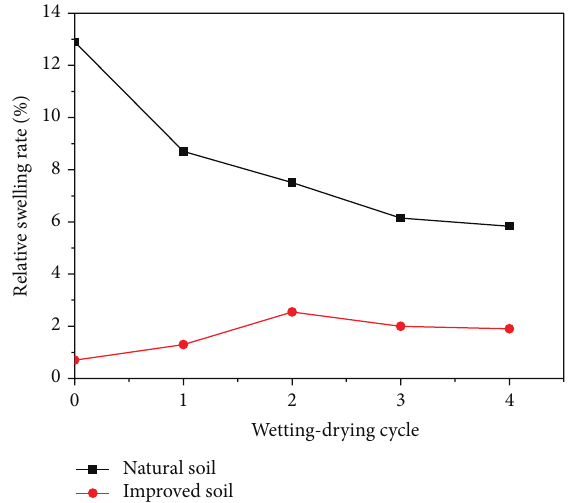
Figure 2: Absolute swelling ratio trends of the natural soil and improved soil.